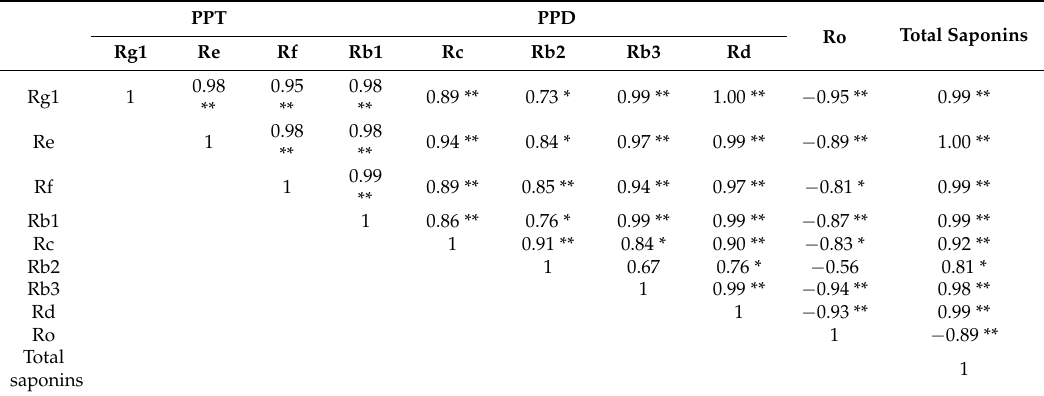
Table 4. Correlation analysis of individual ginsenosides and total saponins in leaves at different growth times. PPT